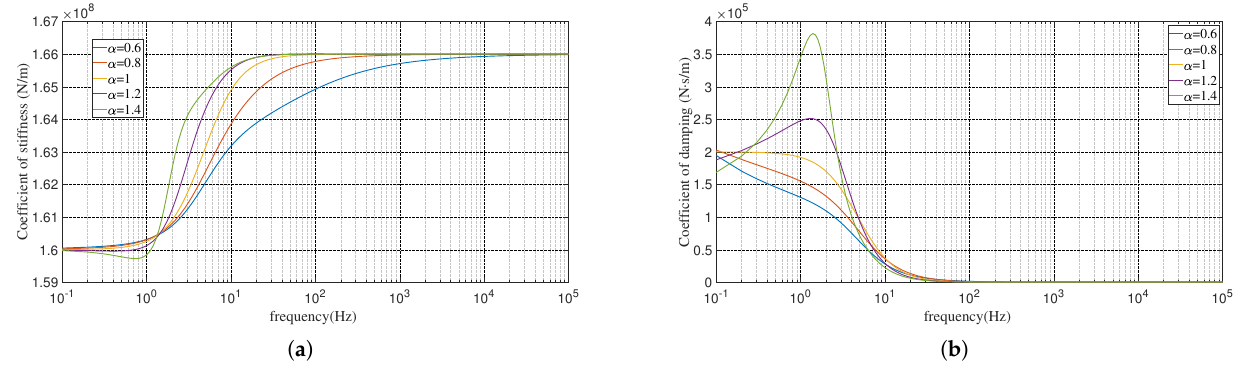
Figure 10. Effect of the fractional order on the dynamic characteristics of the FOMGF model. ( a ) Change of dynamic stiffness with the α order. ( b ) Change of damping with the α